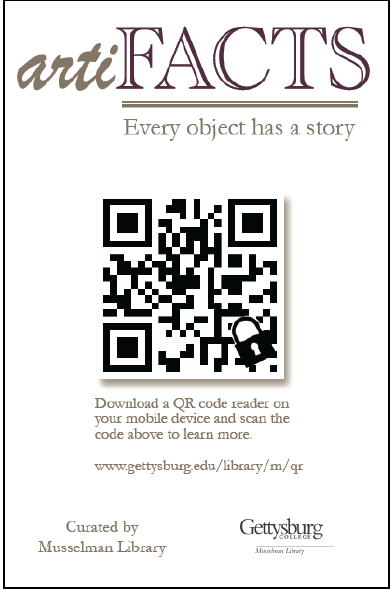
The QR code signs for each object incorporate a “whimsy” like the lock shown here, as well as the artiFACTS logo and instructions for using the QR code.